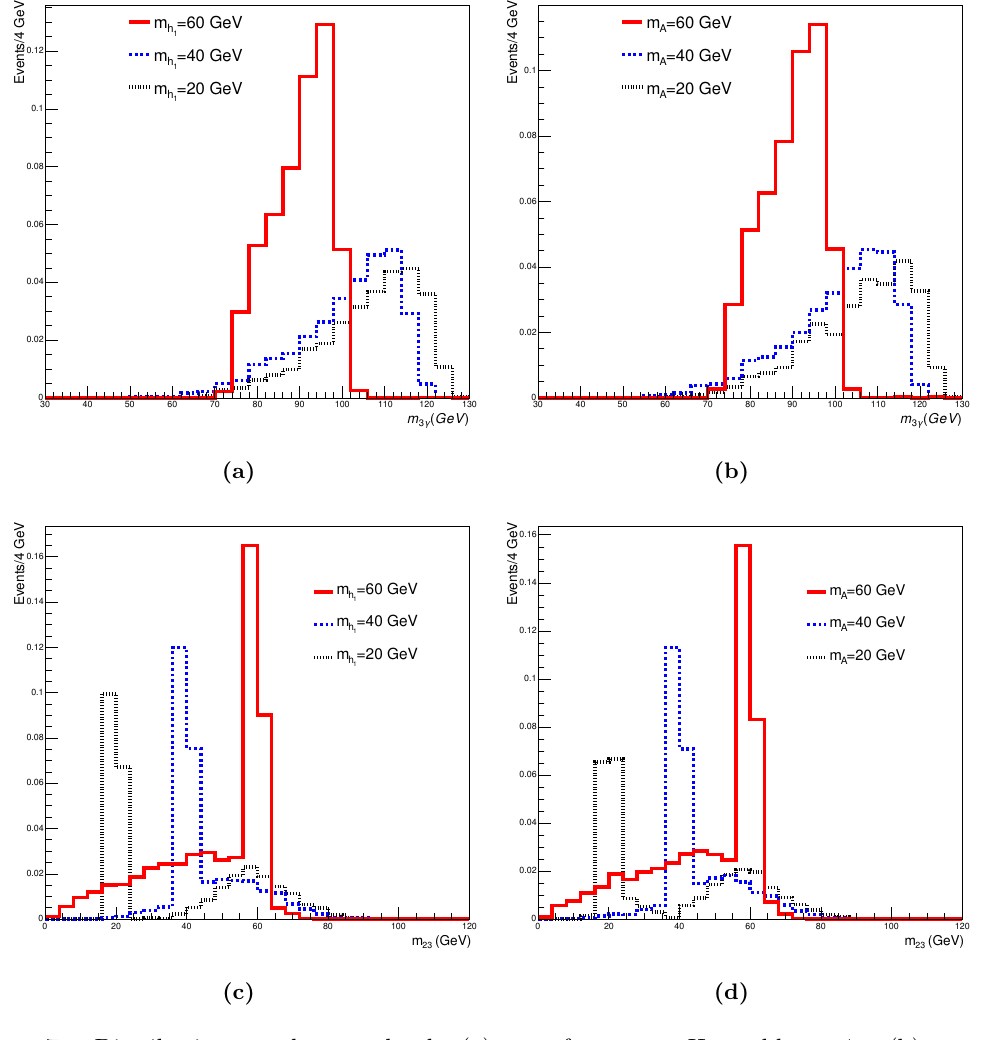
Figure 7. Distributions at detector level: (a) m 3 (cid:13) for gg ! H ! hh ! 4 (cid:13) , (b) m 3 (cid:13) for gg ! H ! AA ! 4 (cid:13) , (c) m 23 for gg ! H ! hh ! 4 (cid:13) and (d) m 23 for gg ! H ! AA ! 4 (cid:13)